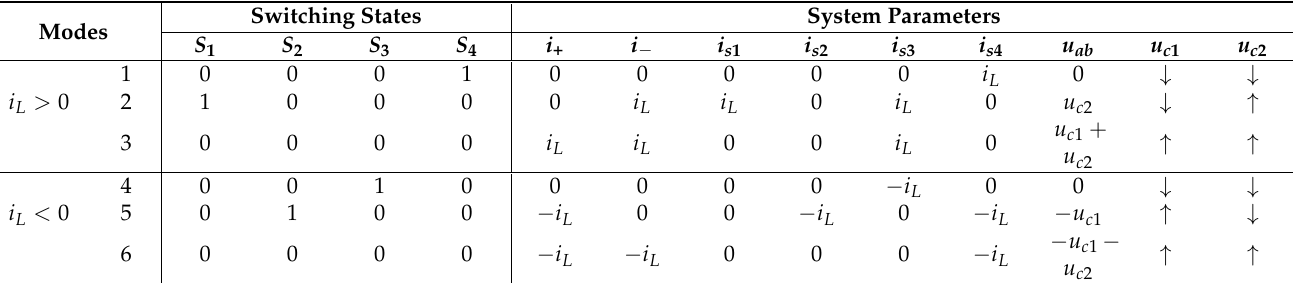
Table 1. Switching states and system